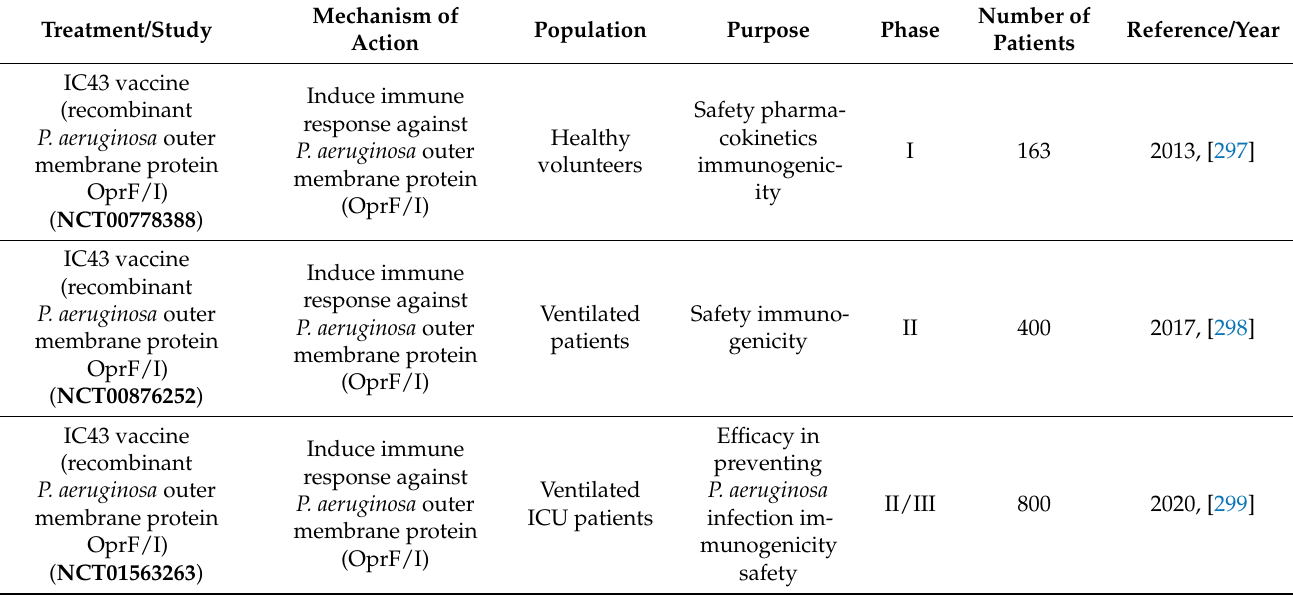
Table 5. P. aeruginosa outer membrane proteins as a